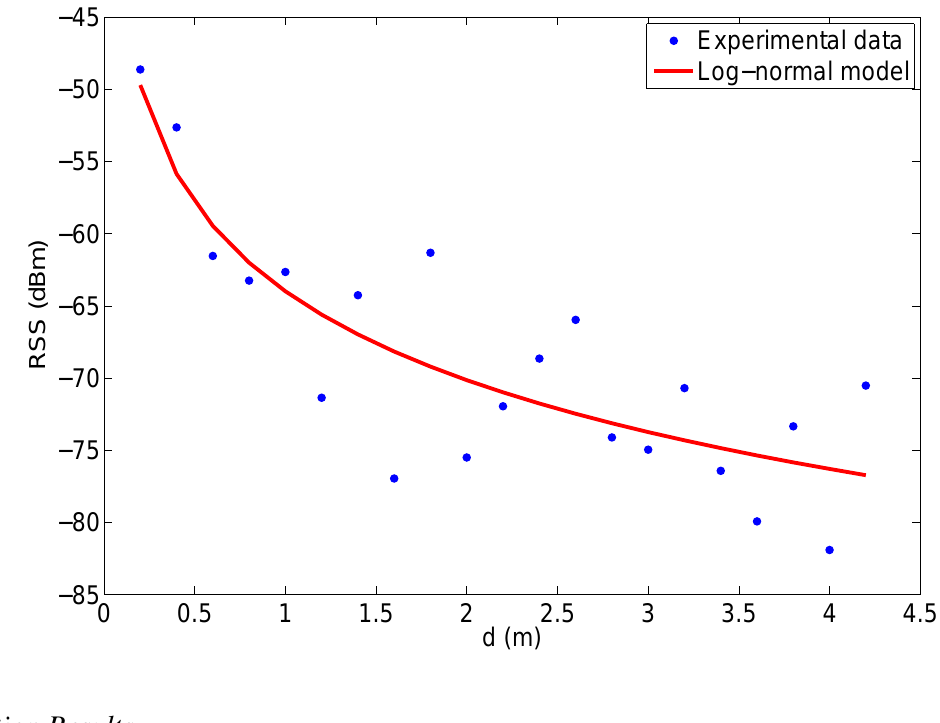
Figure 8. Experimental RSS measurements for different distances between two MICAz nodes. The log-normal channel model curve fitting is also